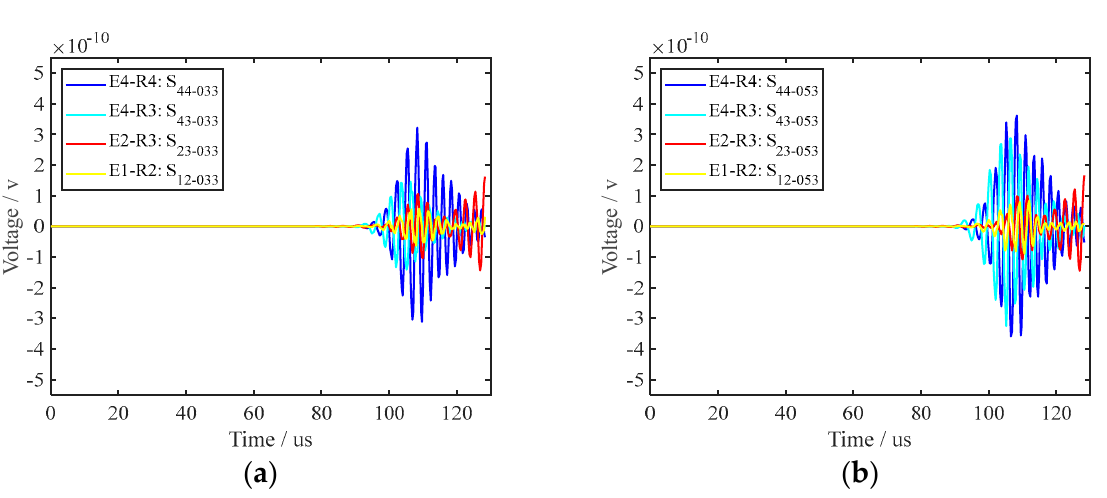
Figure 11. Signal amplitude variation in each path for cracks with small depths; ( a , b ) are the crack depths 3.3 mm and 5.3 mm, respectively.